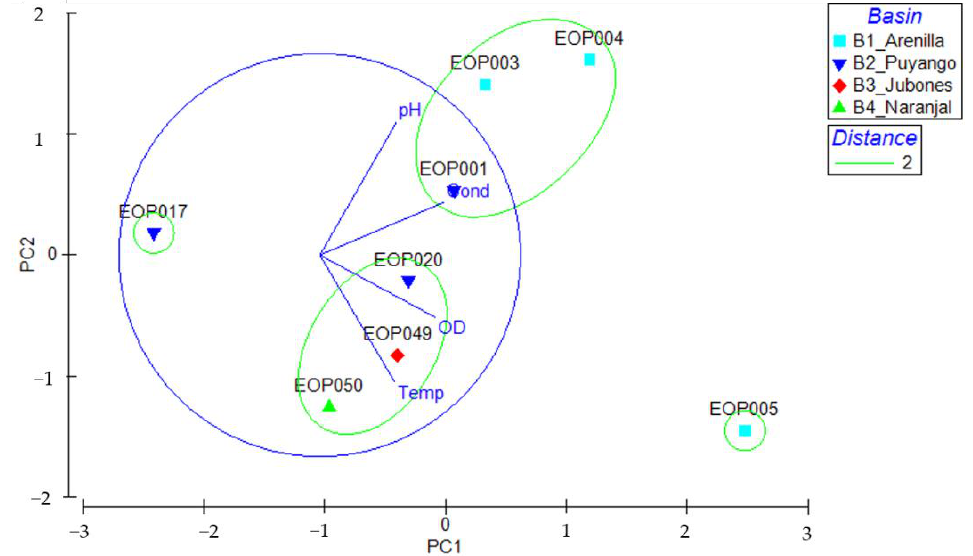
Figure 2. Principal Component Analysis (PCA) for environmental variables with overlaid average clustering from El Oro Province watersheds: B1: Arenillas, B2: Puyango, B3: Jubones, and B4: Siete River. Table 2. El Oro’s Polypedilum morphotypes measurements, mean (min-max). HC: Head capsule; AS: Antennal segment; MC: Mentum central teeth length; M1: Mentum first teeth length; PP: Paralabial plates. p-dist: Pairwise